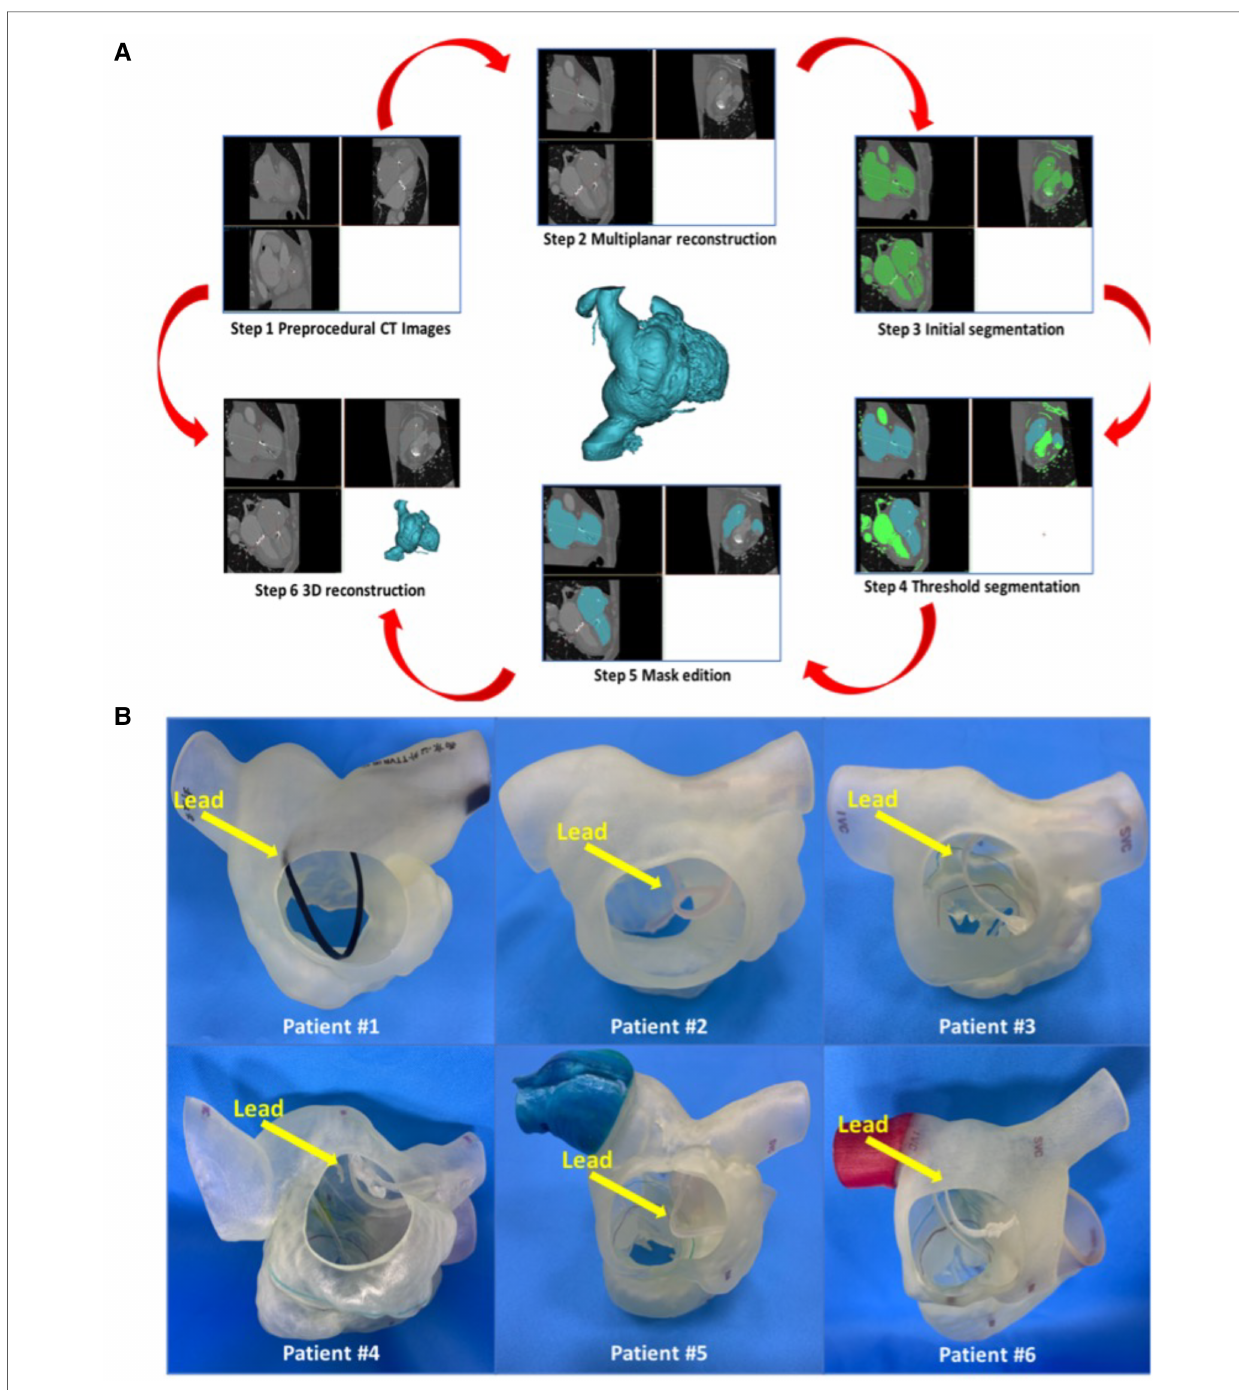
FIGURE 3 Preoperative 3D reconstruction and 3D-printed models of all 6 patients to help surgeons understand anatomical structures and make an accurate surgical plan. ( A ) The process of 3D reconstruction using Materialise Mimics version 21.0 (Materialise, Leuven, Belgium). ( B ) 3D-printed models of all 6 patients ’ right cardiac systems in the RA view. The yellow arrow heads to the lead of the permanent pacemaker. RA, right atrium; 3D,